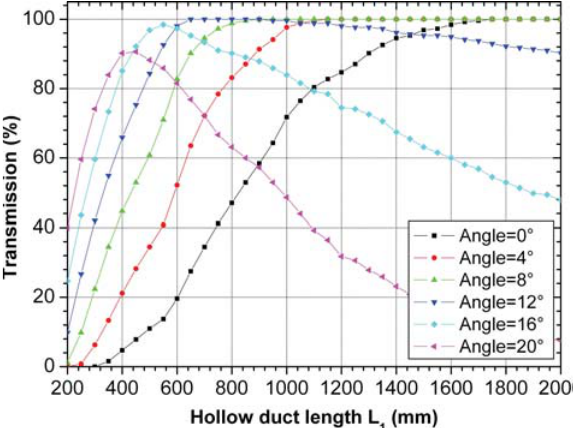
Fig. 3. Hollow-duct transmission as a function of its length L 1 for di ff erent value of laser-diode emission angles ϕ ; reflection losses from the sidewalls are not taken into account. Performed for sim-